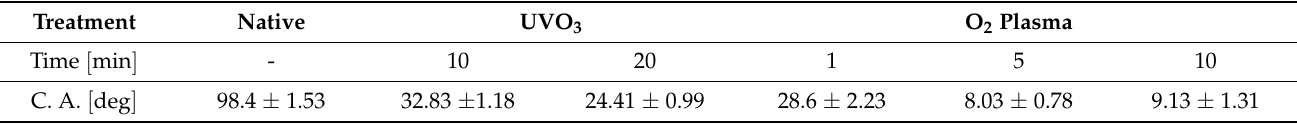
Figure 2. Contact angle measurement of COP. ( A ) Native; ( B , C ) after UVO 3 surface treatment (10 and 20 min, respectively); ( D – F ) after O 2 plasma treatment (1, 5, and 10 min, respectively). Table 2. Contact angle measurements of COP, natively and after surface treatment. (Mean values and standard deviations for N = 3 samples). Treatment Native